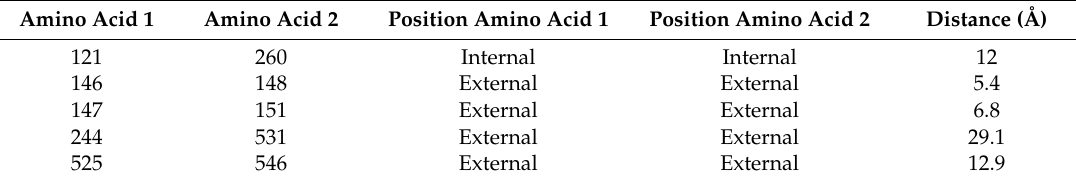
Table 3. Pairs of spike amino acids proven to co-evolve. For each pair, the position of the involved amino acids and their distances are